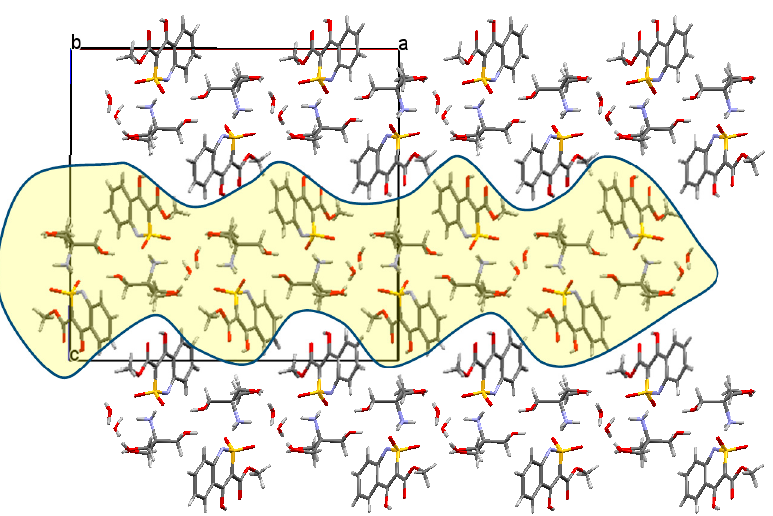
Figure 6. Packing of molecules in the structure of salt 5a , projection along the crystallographic direction [0 1 0], the layers are marked in yellow.